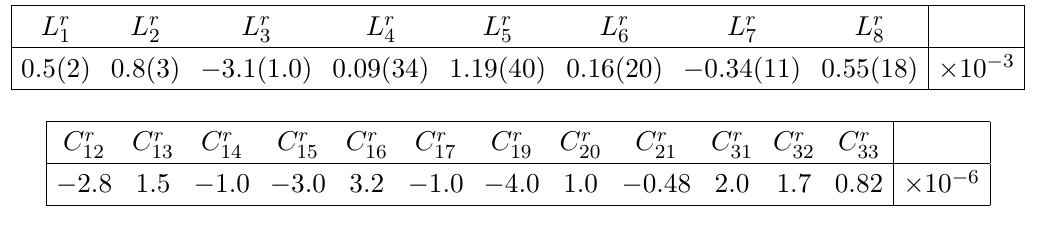
Table 5 . Numerical value of the NLO and NNLO couplings L r We associated 100% uncertainty to the C r